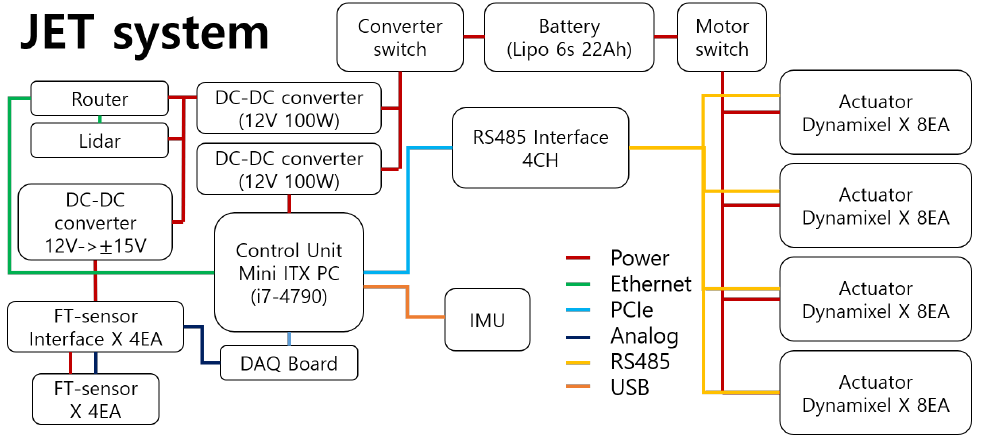
Figure 4. Electrical system diagram of